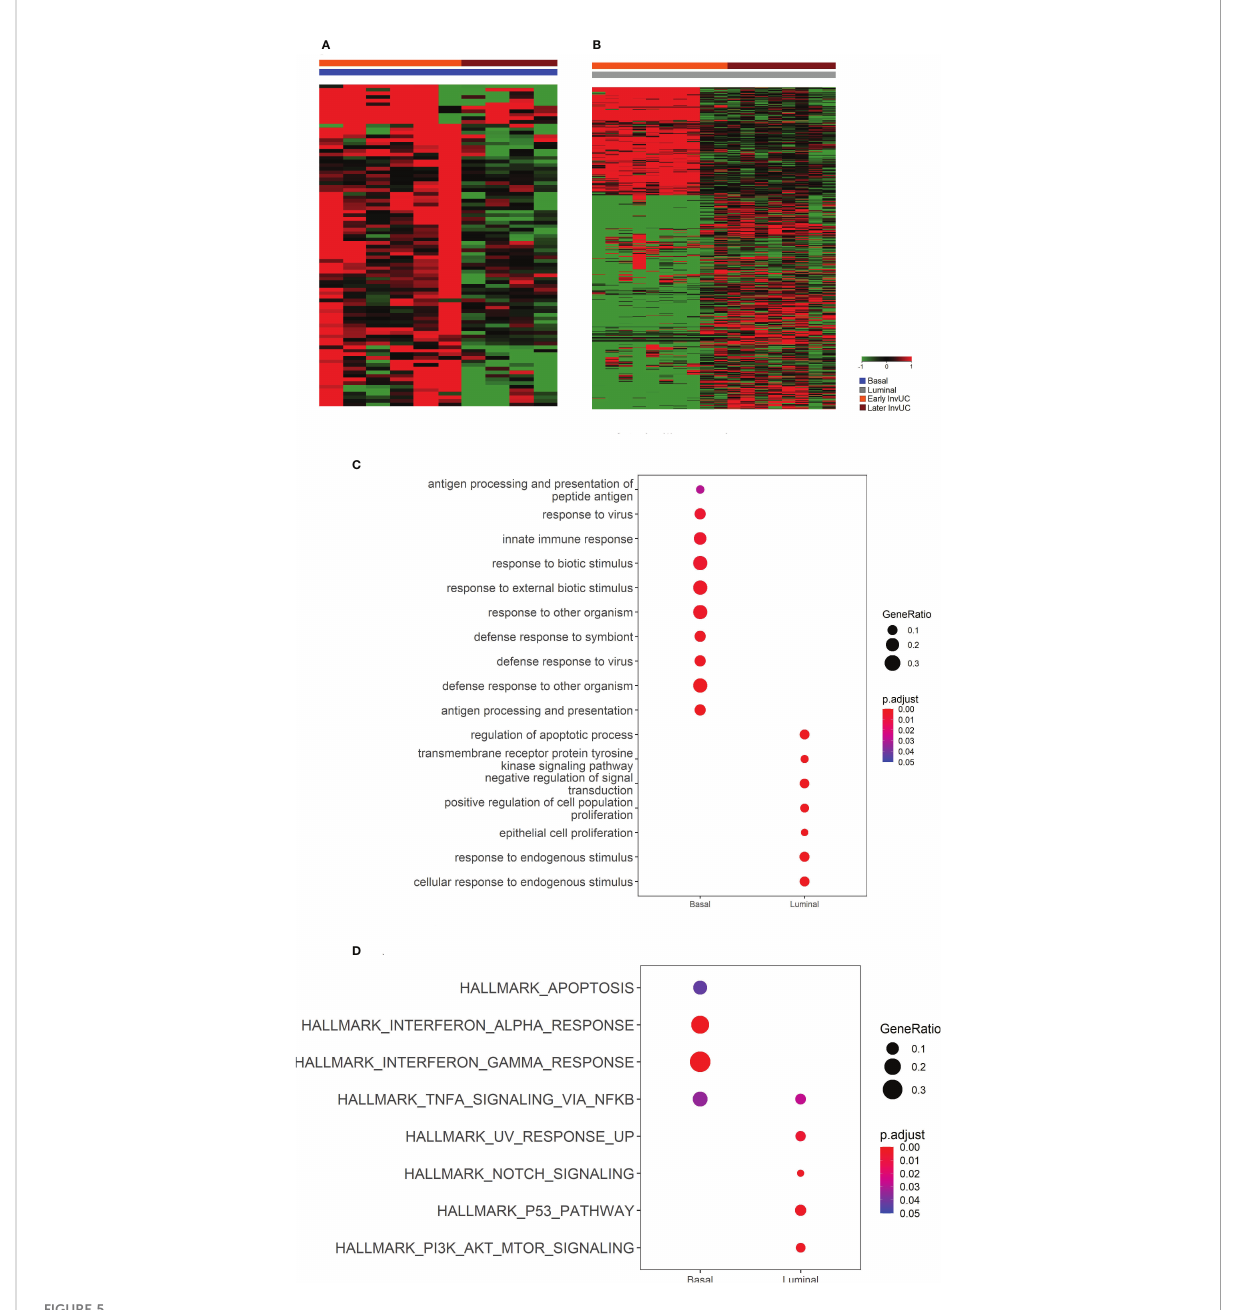
FIGURE 5 RNA-seq and Gene Set Enrichment Analyses (GSEA) demonstrating differences between early and later canine invasive urothelial carcinoma (InvUC) within each molecular subtype. This part of the study was done to search for genes that differed in expression between early and later tumors. In the heatmaps (A, B) , each column represents data from one sample, and the samples are grouped according subtype and time of detection (see key). CompareClust was utilized to identify Gene Ontology (GO) terms (C) and Hallmark pathways (D) that differed between the early and later tumors within each subtype. The gene ratios from the GO and Hallmark pathway analyses are indicated by the size of the dot, and the P value is indicated by color scale in the key (C, D) . Substantial differences were found between early luminal and later luminal tumors including GO terms related to proliferation and apoptosis, and Hallmark pathways related to proliferation such as PI3K-AKT-mTOR and TP53 pathways. In Ingenuity Pathway Analysis, the later luminal tumors also had upregulation of Cell Cycle Control of Chromosomal Replication, CDK, EGF, FGFR1, NRAS , and RRAS genes, and downregulation of HIPPO signaling and Cell Cycle G1/S Checkpoint Regulation (Table 2). Differences between the early and later basal tumors were limited, but when present included GO terms and Hallmark pathways related to apoptosis, and the immune